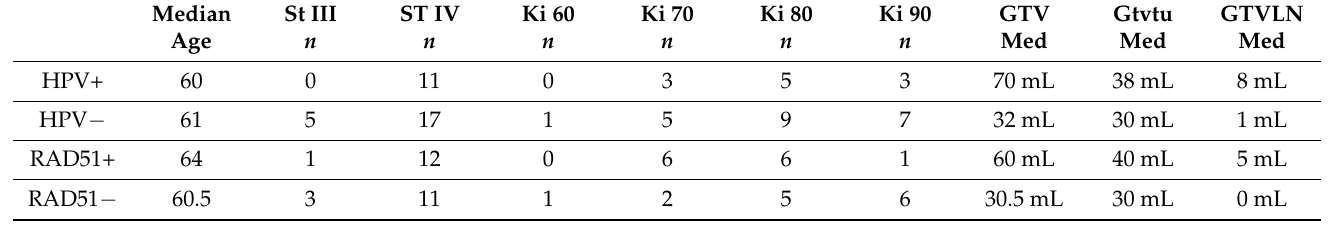
Figure 5. Kaplan–Meier curves of the 5-year survival for RD51+ and RAD51 − patients. Table 1. The median age, stage of the disease, Karnofsky index, and gross volumes in HPV positive+ vs. negative − and RAD51+ vs. RAD51 − patients.